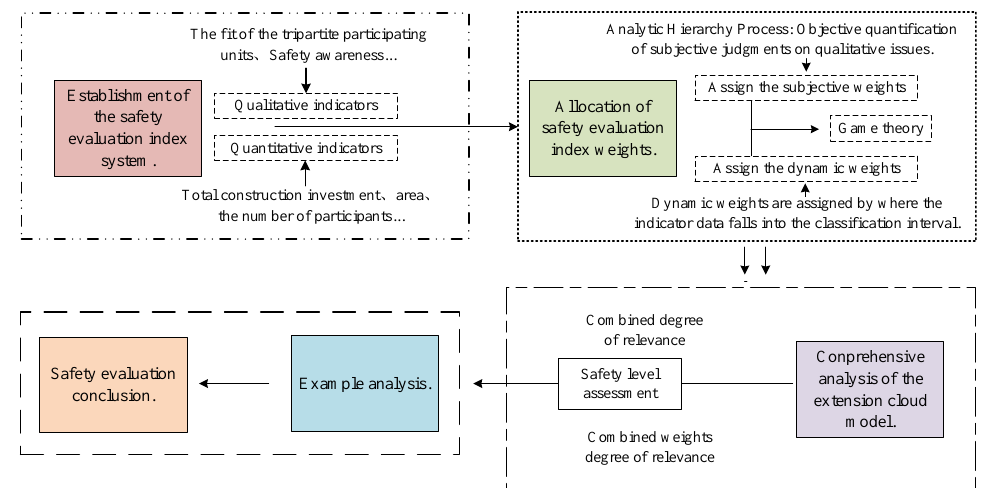
Figure 2. Research method